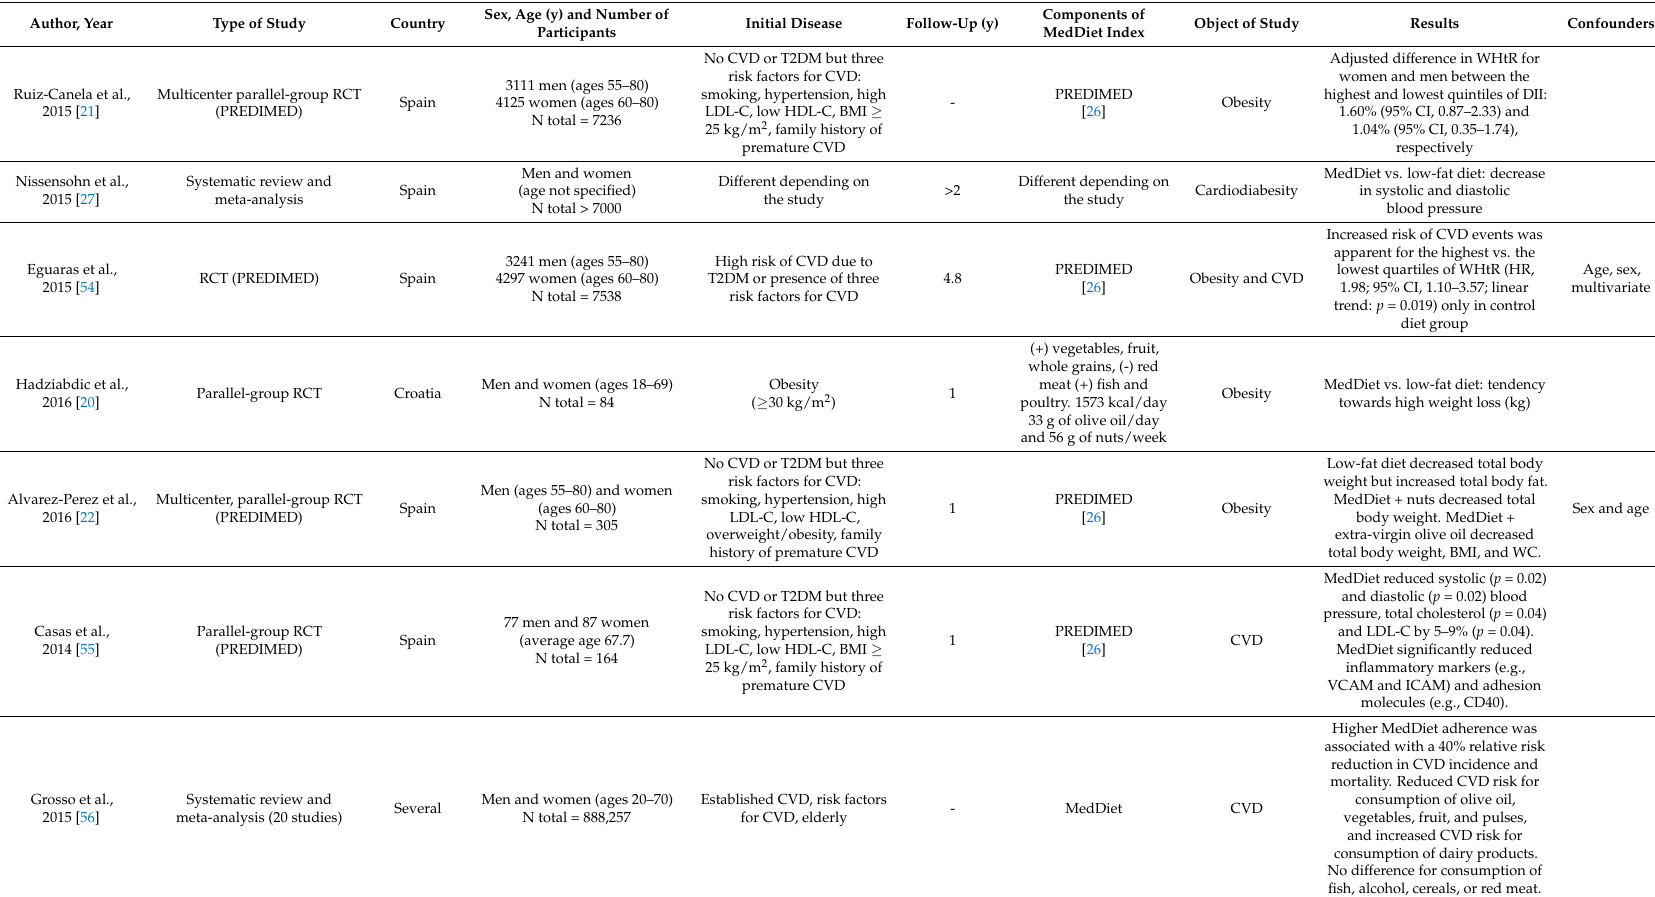
Table 4. Articles included in this review published between October 2013 and July